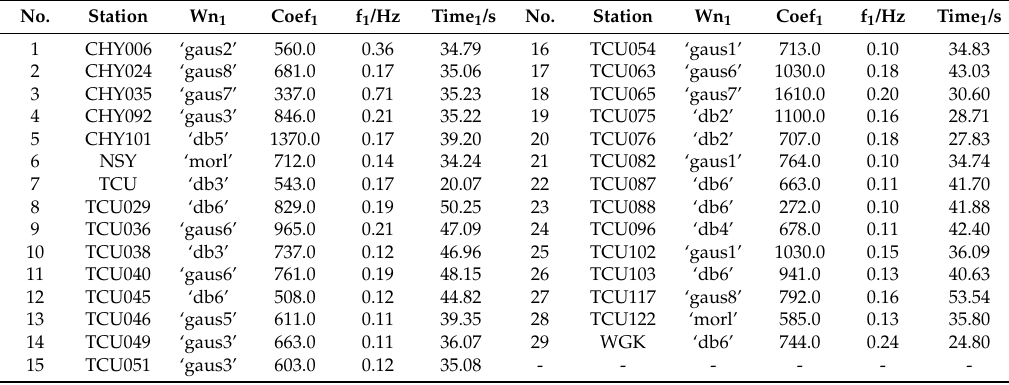
Table 2. The wavelet parameters for the earthquake motions qualified as pulse-like with one mother